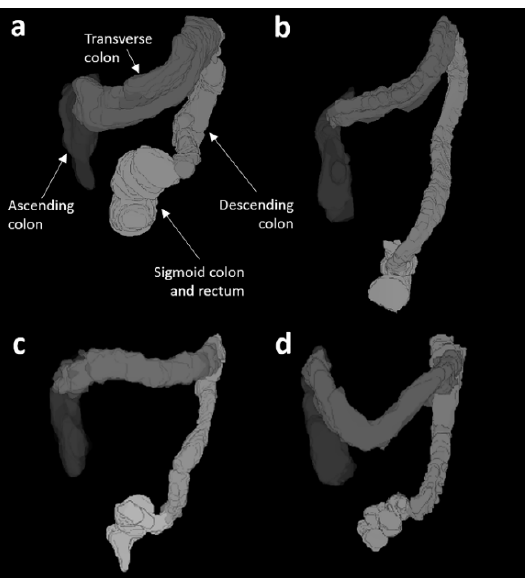
Figure 1. 3D representations of the colon morphology from four different participants whose characteristics were: ( a ) patient, 13 years old, weight 42 kg, height 154 cm, BMI 17.7 kg/m 2 , total colon volume (TCV) = 712 mL, whole gut transit time (WGTT) = 140 hs; ( b ) healthy control, 17 years old, weight 80 kg, height 185 cm, BMI = 23.4 kg/m 2 , TCV = 360 mL, WGTT = 16 hs; ( c ) patient, 9 years old, weight 48 kg, height 130 cm, BMI 21.4 kg/m 2 , TCV= 237 mL, WGTT = 75 hs; ( d ) healthy control, 10 years old, weight 42 kg, height 145 cm, BMI = 19.9 kg/m 2 , TCV = 227 mL, WGTT = 26 hs.